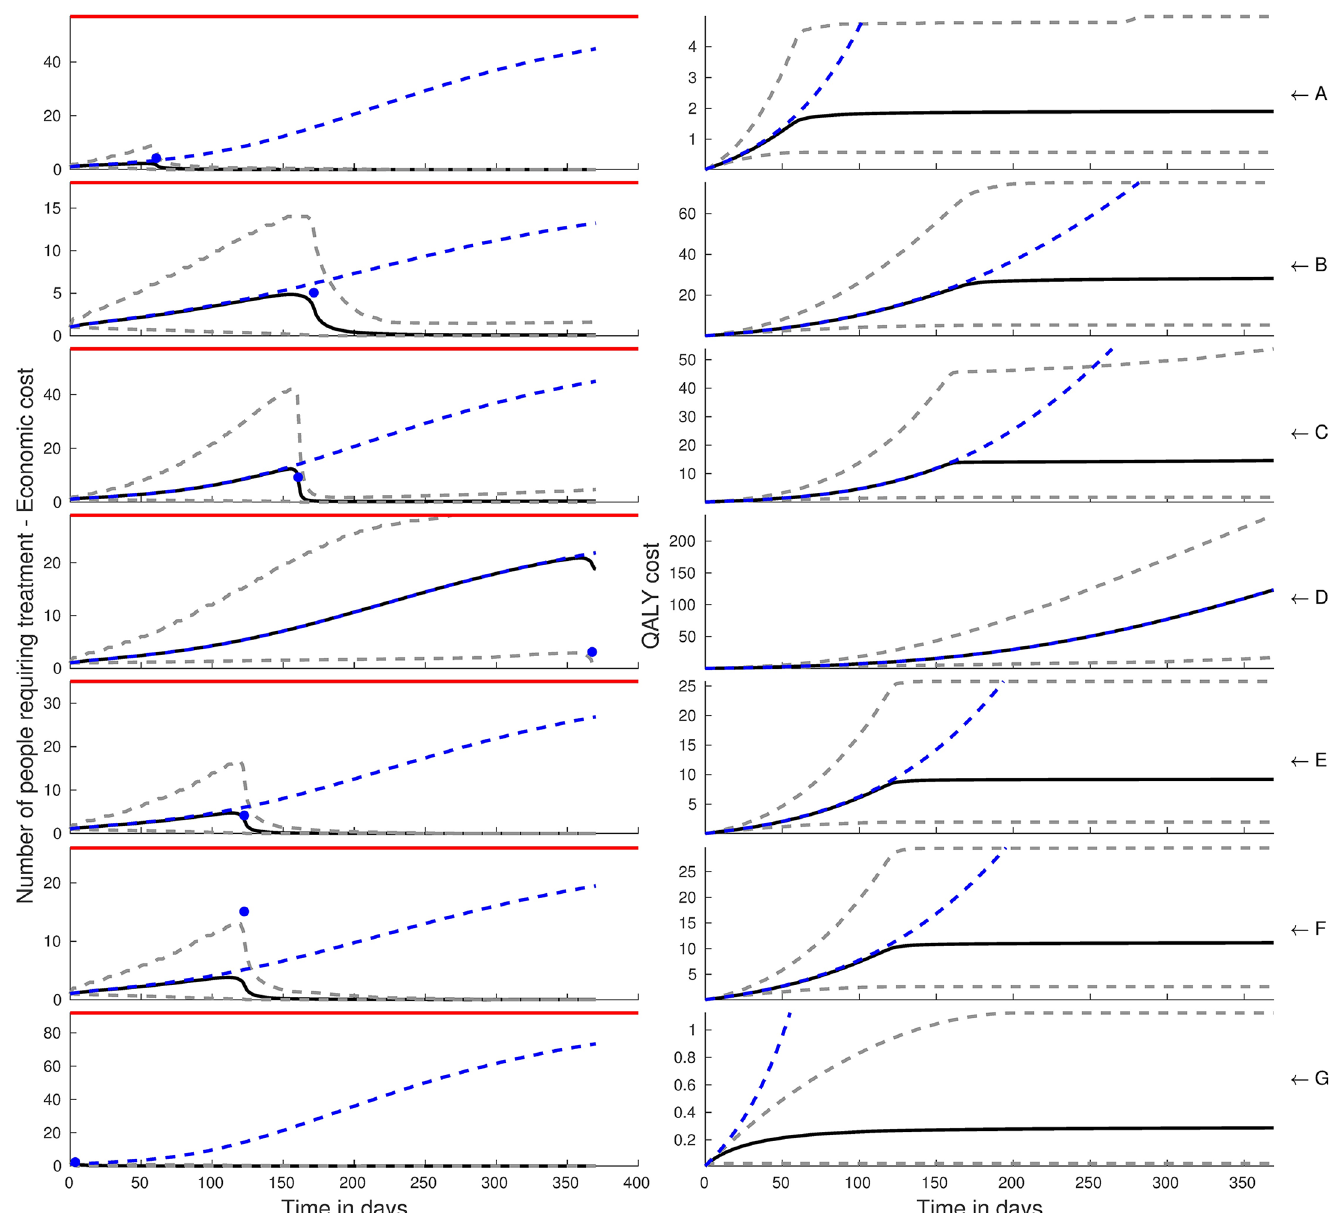
Fig 4. The first column shows the model predictions of the number of infected individuals before and after a course (two doses) of permethrin or two doses of ivermectin with an assumed efficacy of 96.9%. Treatment is done once at the time the observation of cases (blue circles). The mean of the model predictions is given by the black solid lines while the dashed lines grey are the 95% CI. The blue dashed lines are the means of the model predictions in the absence of treatment with the red lines showing the care home size. The plots in the second column represent the QALY cost associated with each care home (A to